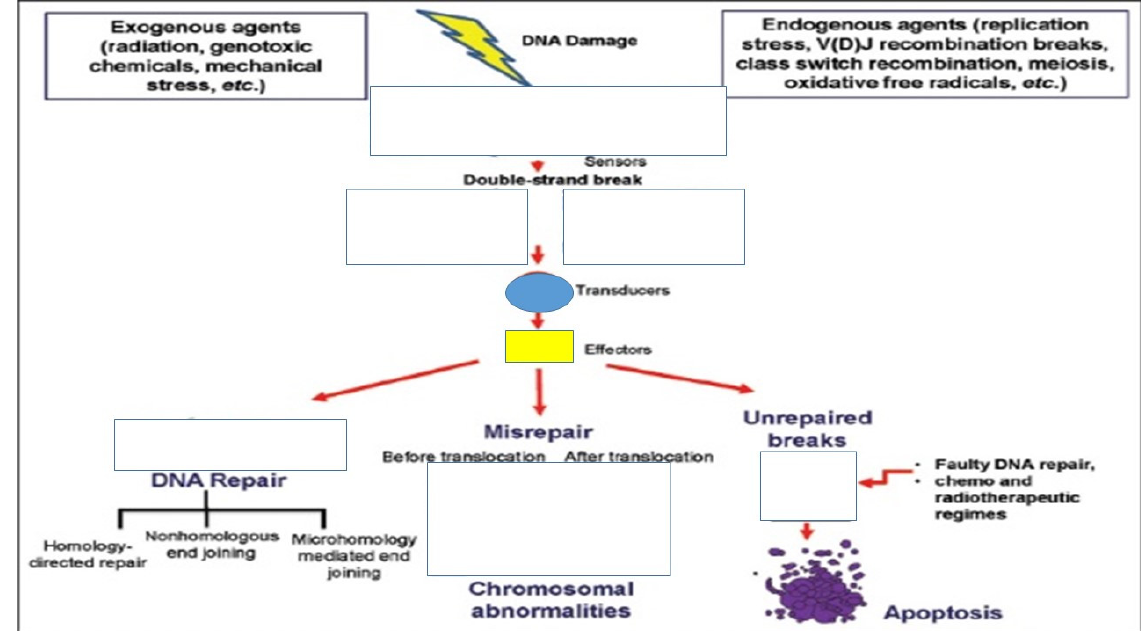
Figure 3. DNA damage response to a double strand break .